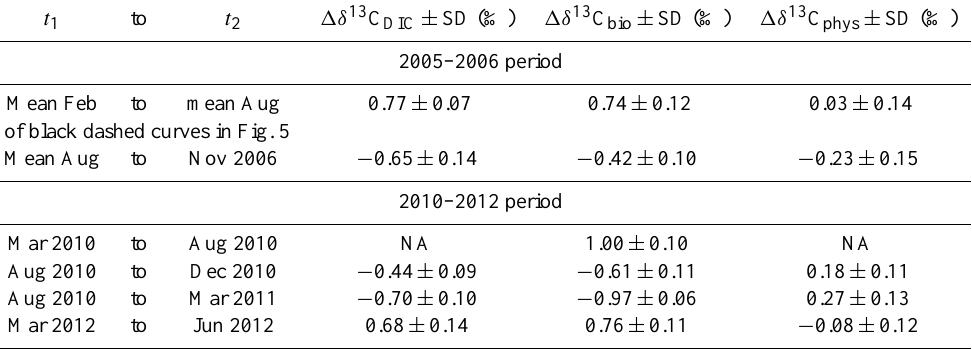
Table 2. Seasonal ( t 1 to t 2 ) amplitude of δ 13 C DIC ( 1δ 13 C DIC ) and their standard deviation (SD). The biological and physical contributions ( 1δ 13 C bio and 1δ 13 C phys , respectively) for the 2005–2006 and 2010–2012 periods estimated from Eqs. (4) and (5). t 1